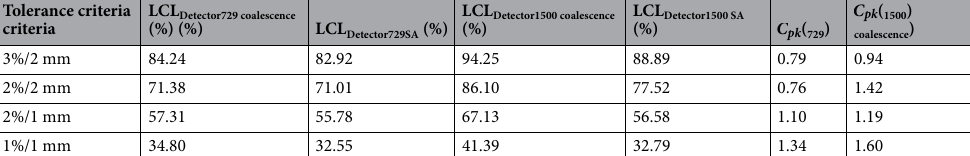
Table 3. Lower control limits (tolerance limits) in each cohort and process capability index values. LCL lower control limit, C pk process capability index.